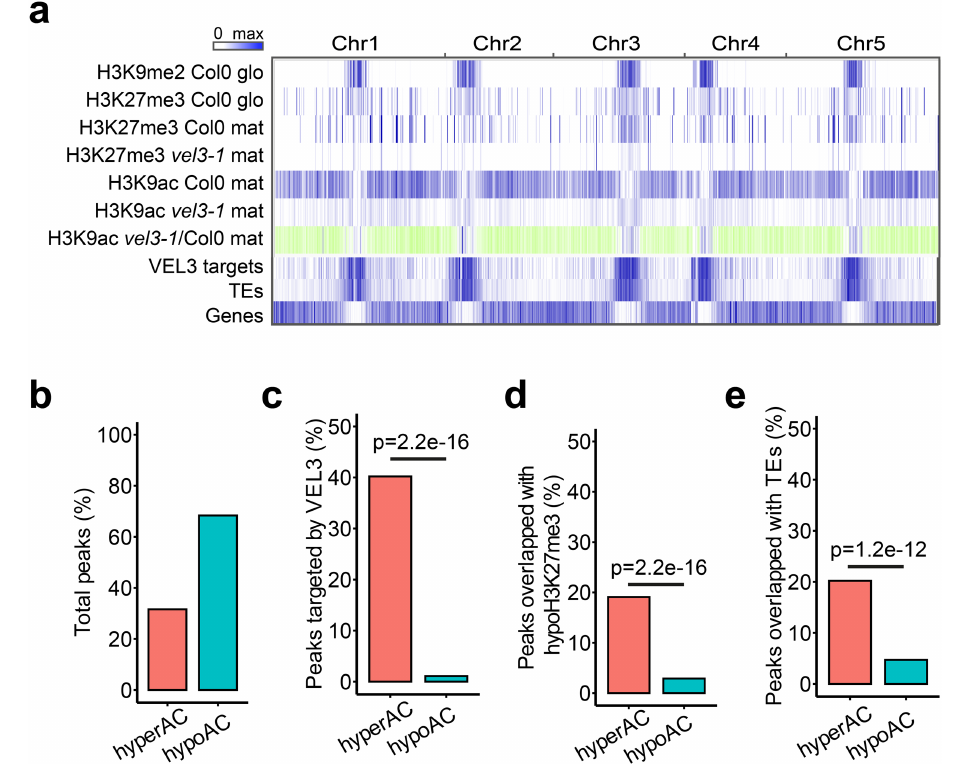
Fig.7|VEL3isrequiredforH3K9Actopericentromericregions.a Genome-wide distribution of H3K9me2, H3K27me3,and H3K9ac in Col-0and vel3-1 (glo-globular embryostage;mat-matureendosperm.Bluecolorindicatestheregionsmarkedby the indicated epigenetic modi fi cation, VEL3-direct targets by ChIP-seq and